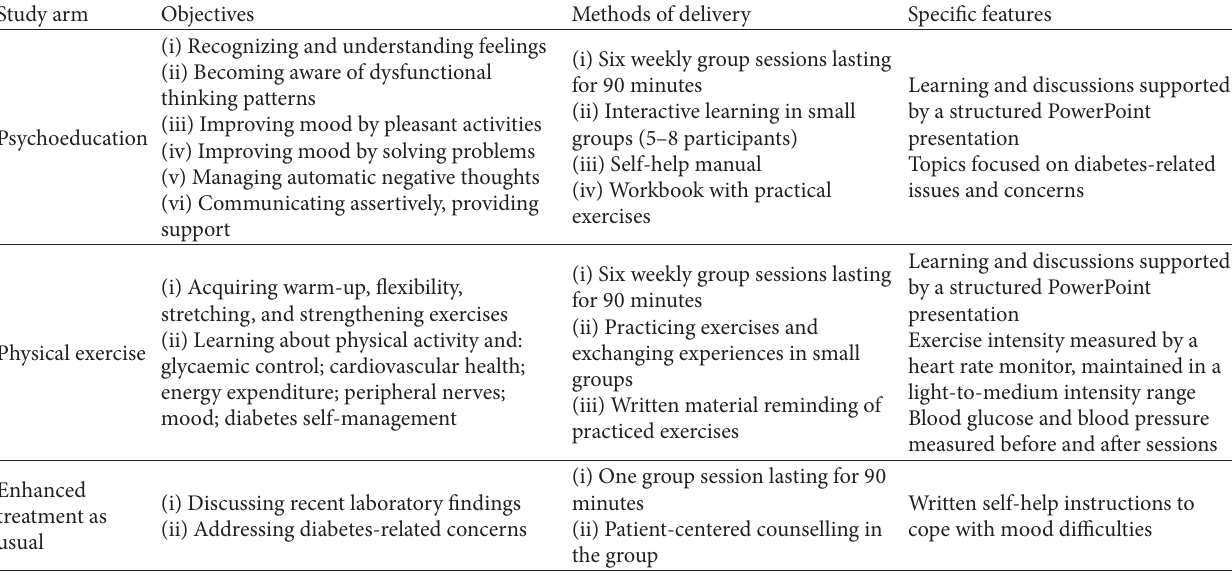
Table 1: Programs’ objectives, methods of delivery, and specific